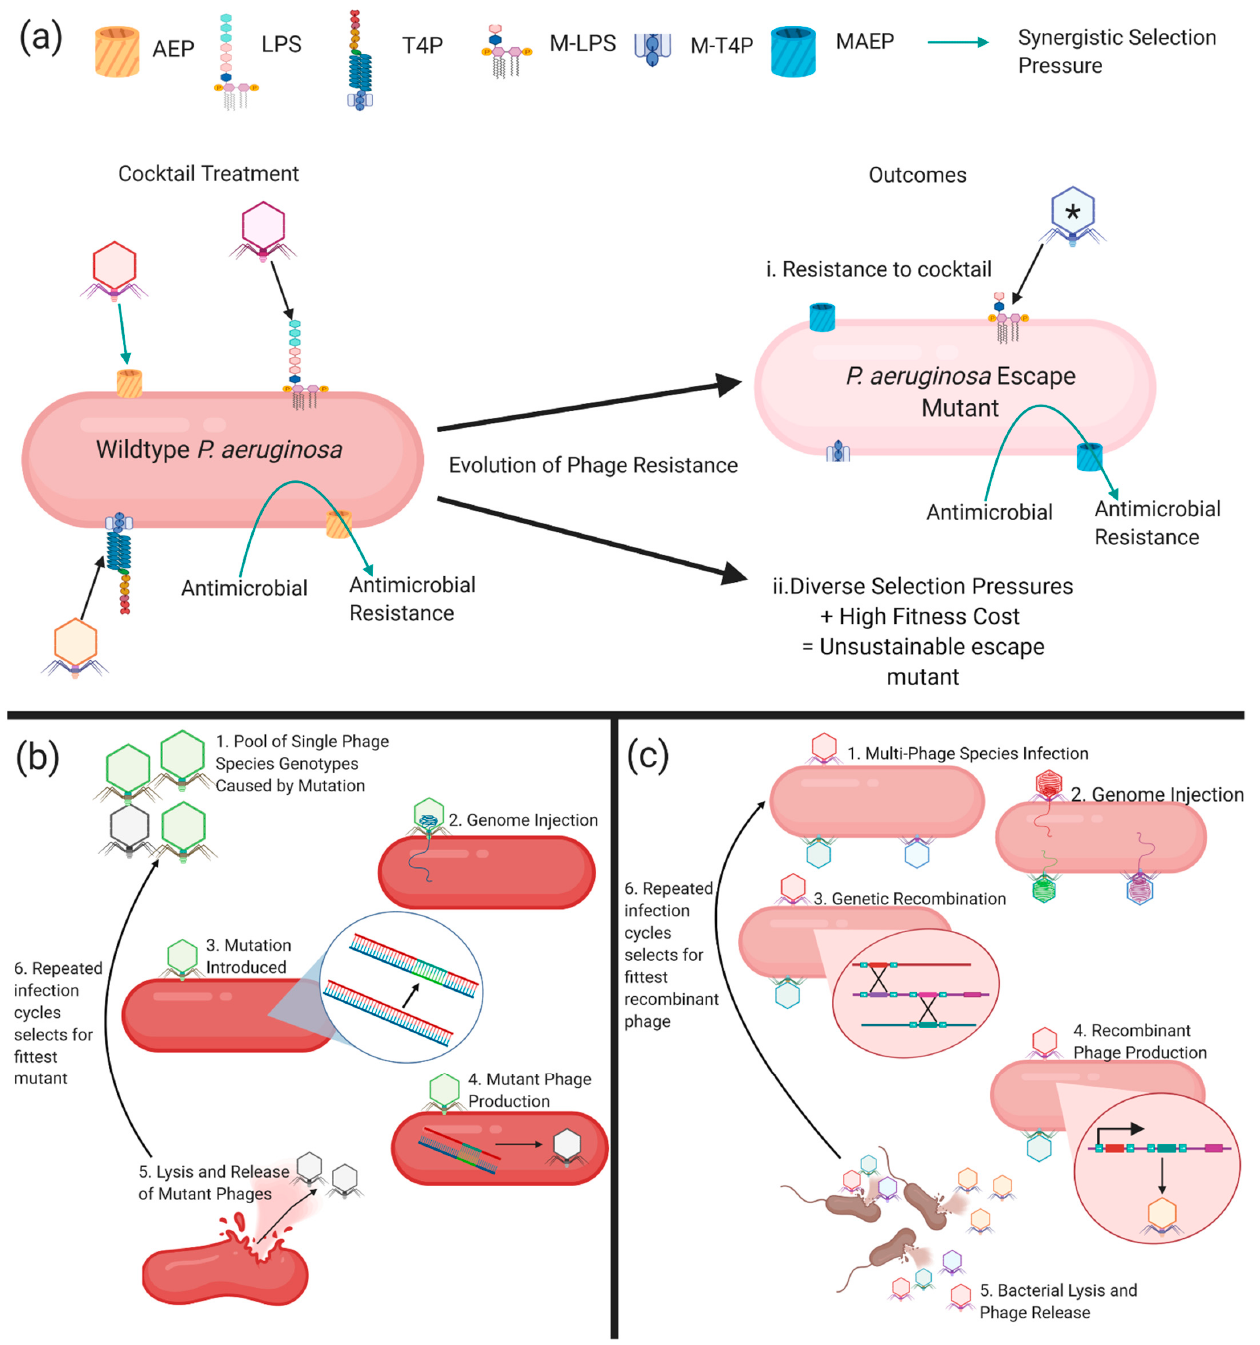
Figure 2. ( a ) The rationale for strategic cocktail formulation. Cocktails contain phages that use different receptors like lipopoly- saccharide (LPS), type IV pili (T4P,) or antimicrobial-resistant determinants (antibiotic efflux pumps; AEP) so that their addition